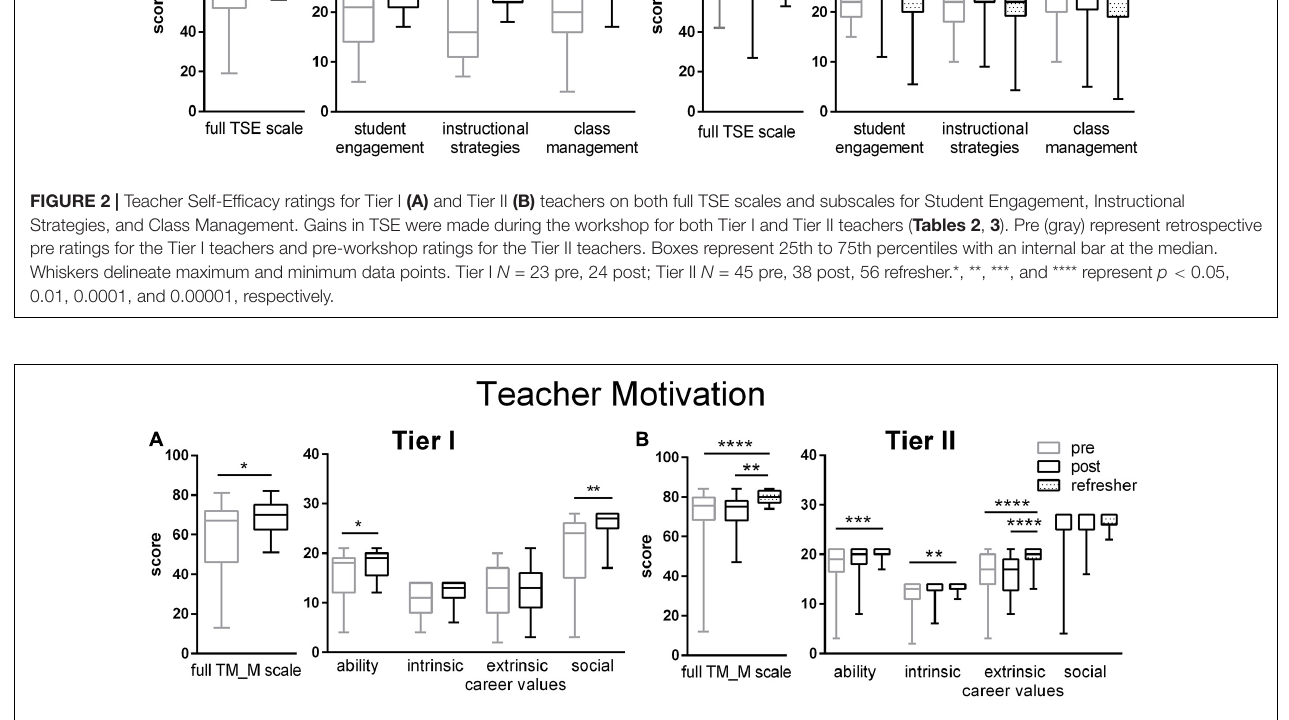
FIGURE 3 | Teachers Motivation to Teach ratings for Tier I (A) and Tier II (B) teachers on both full TM_M scales and subscales for Teaching Ability, Intrinsic Career Values, Extrinsic Career Values and Social Career Values. Gains in Teacher Motivation were made more for Tier II than Tier I teachers ( Tables 2 , 3 ). Pre (gray) represent retrospective pre ratings for the Tier I teachers and pre-workshop ratings for the Tier II teachers. Boxes represent 25th to 75th percentiles with an internal bar at the median. Whiskers delineate maximum and minimum data points. Tier I N = 23 pre, 23 post; Tier II N = 44 pre, 38 post, 56 refresher.*, **, ***, and **** represent p < 0.05, 0.01, 0.0001, and 0.00001, respectively.